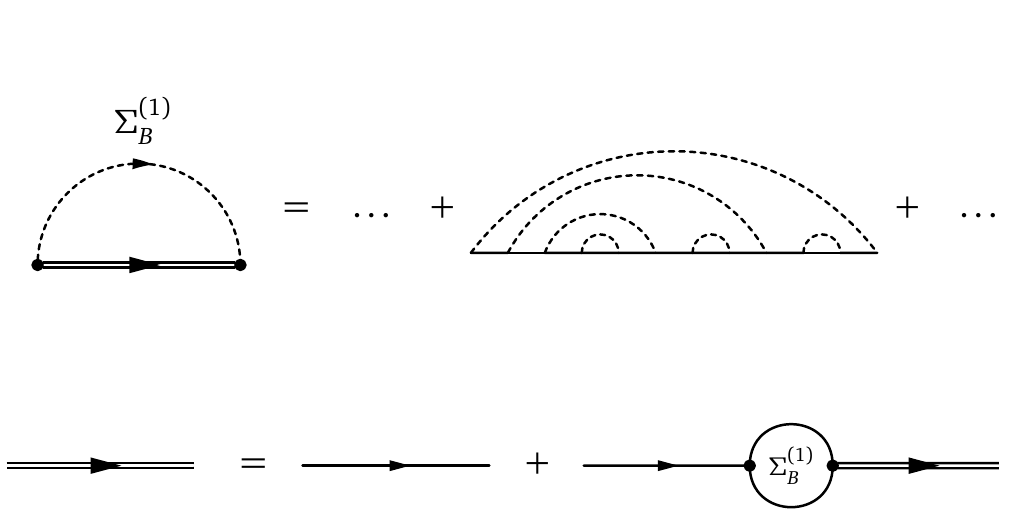
Figure 17: Upper panel: The first-order self-energy Σ ( 1 ) in the self-consistent approximation (known as the non-crossing approximation) and illustration of an included diagram in this approximation for the self-energy. The double line denotes a full electron propagator. Lower panel: the corresponding Dyson equation. In bold diagrammatic Monte Carlo one seeks a self-consistent solution to the above two equations by stochastic means and (usually) some iterative